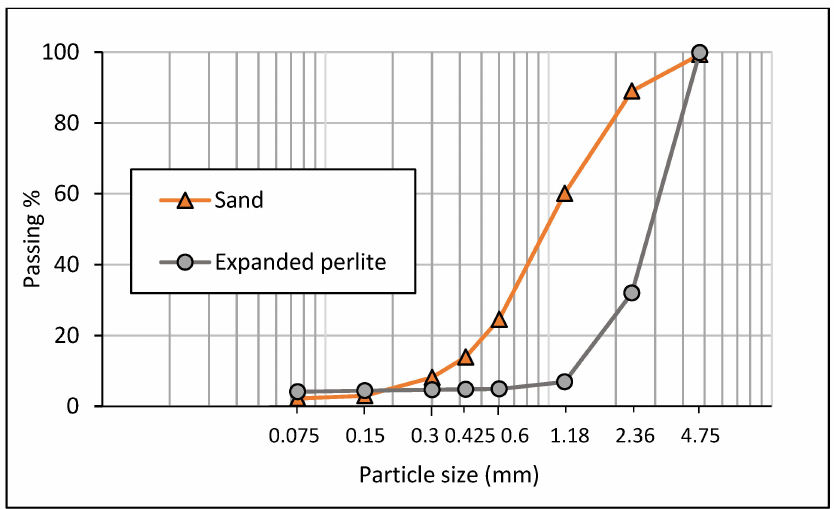
Figure 2. Scanning Electron Microscope (SEM) images of expanded perlite.